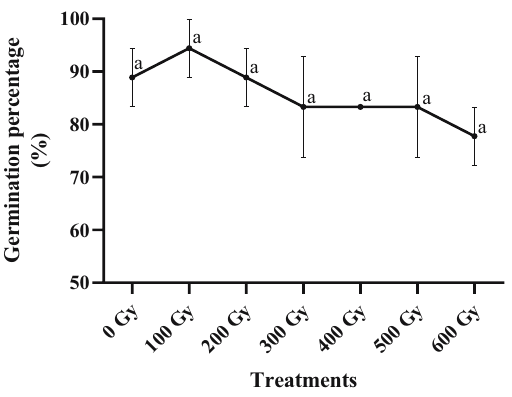
Figure 1: Germination percentage of irradiated wheat var. CIRNO C2008 seeds. Di ff erent letters indicate a signi fi cant di ff erence ( Tukey HSD p < 0.05 )